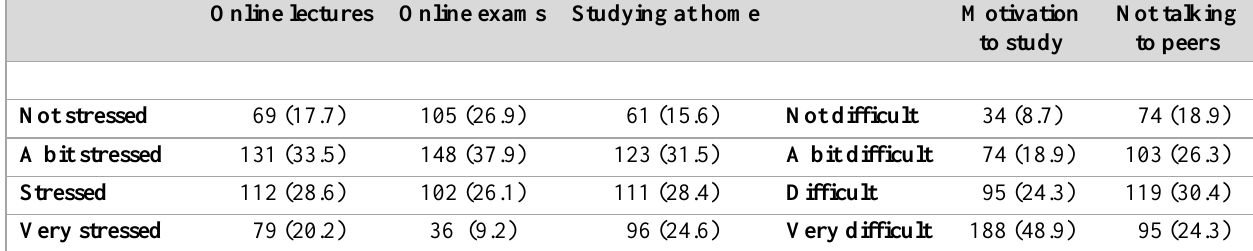
Number and Percentage of Students who Endorsed each Response for the Five Online Learning Questions